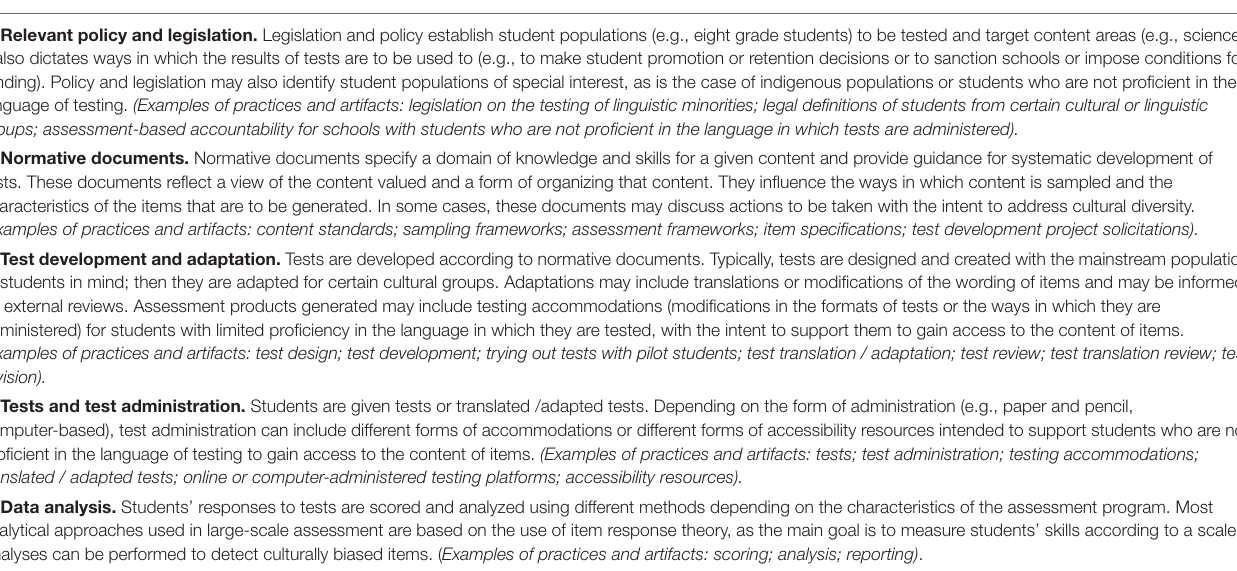
TABLE 1 | Assessment process components with examples of assessment practices and